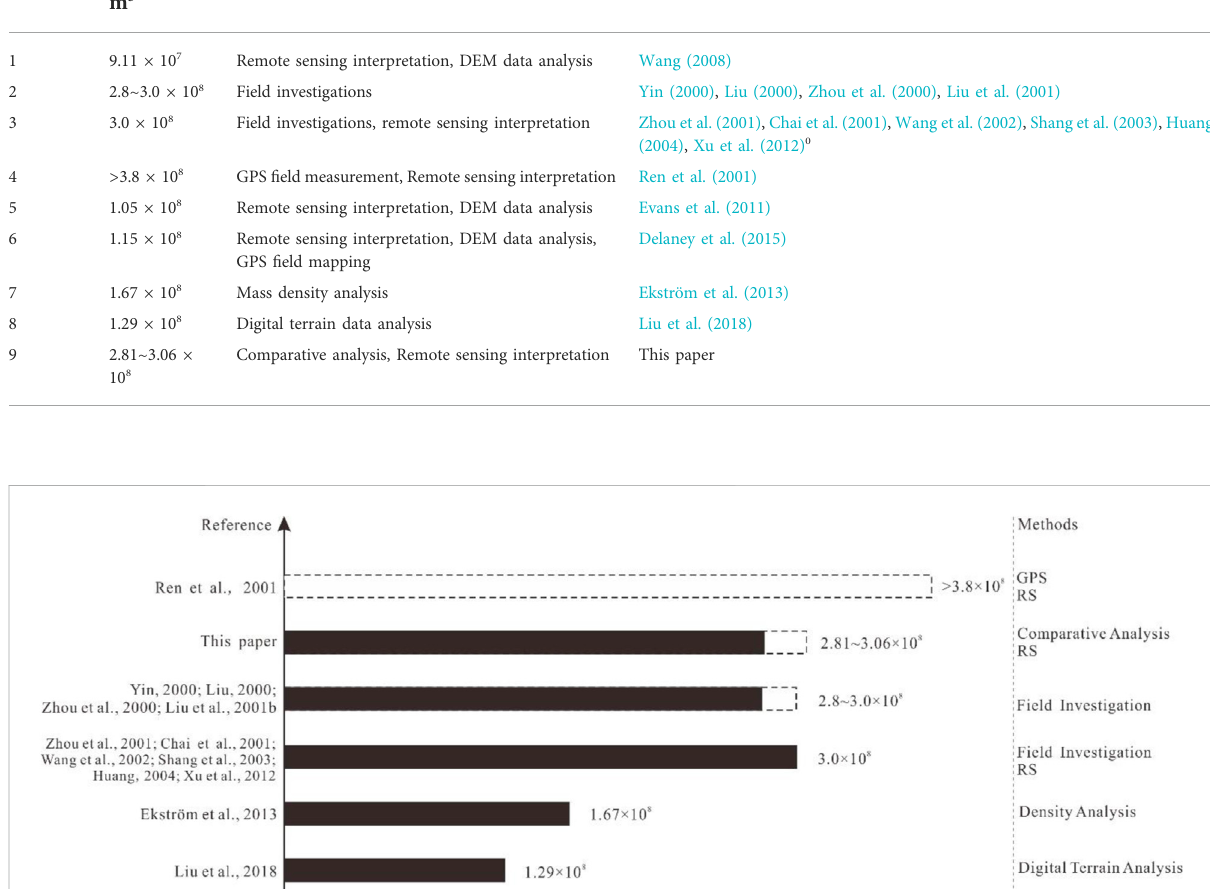
TABLE 3 Historical studies summary of fi nal deposition volume of the Yigong landslide in 2000.